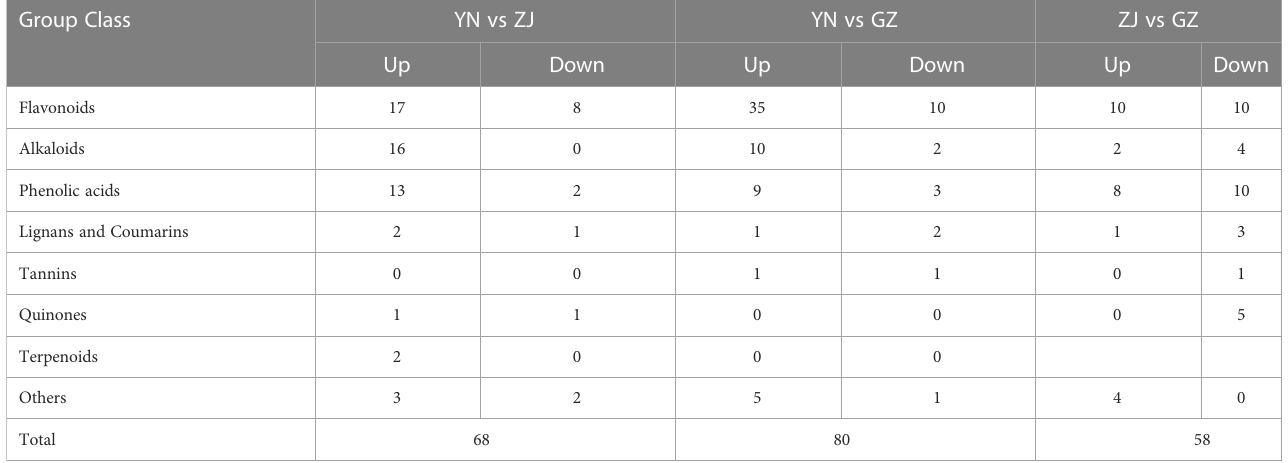
TABLE 3 Number of differential metabolites in the leaves of Dendrobium of fi cinale from different provenances. Group Class